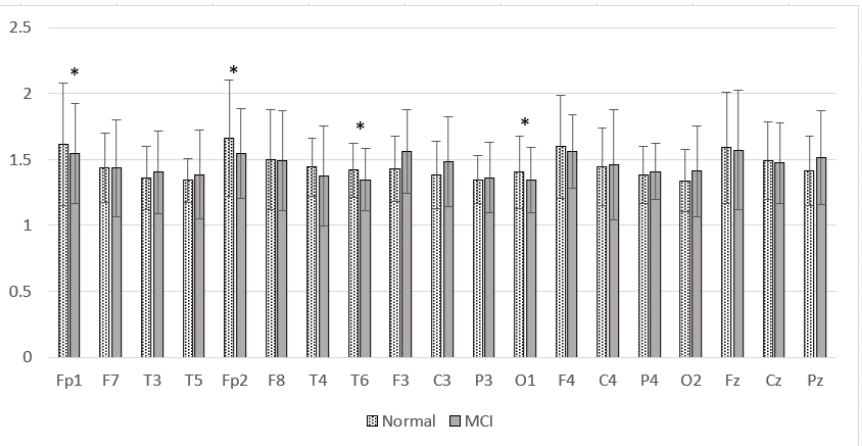
Figure 19. Mean of the SpecEn values of the normal and MCI groups. * p < 0.05.